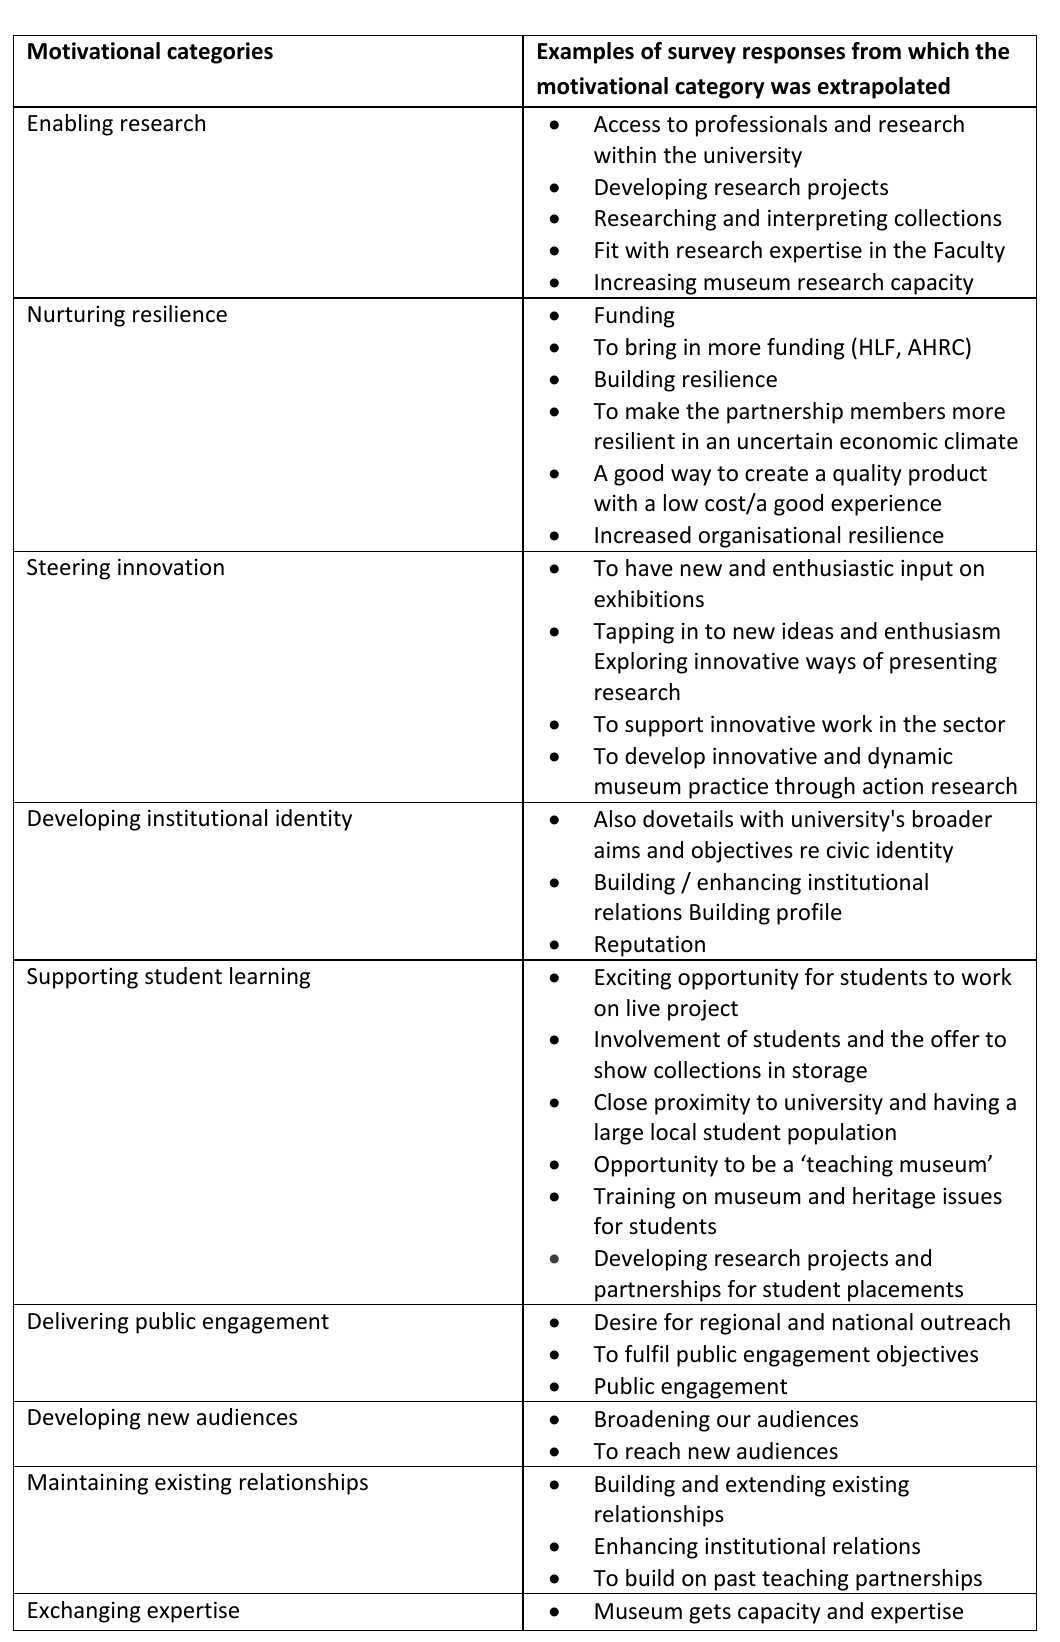
Table 5. Motivational categories extrapolated from answers to the survey question: “What are the main motivations that led your organisation to get involved in the partnership?”. Example of survey answers for each motivational category are also